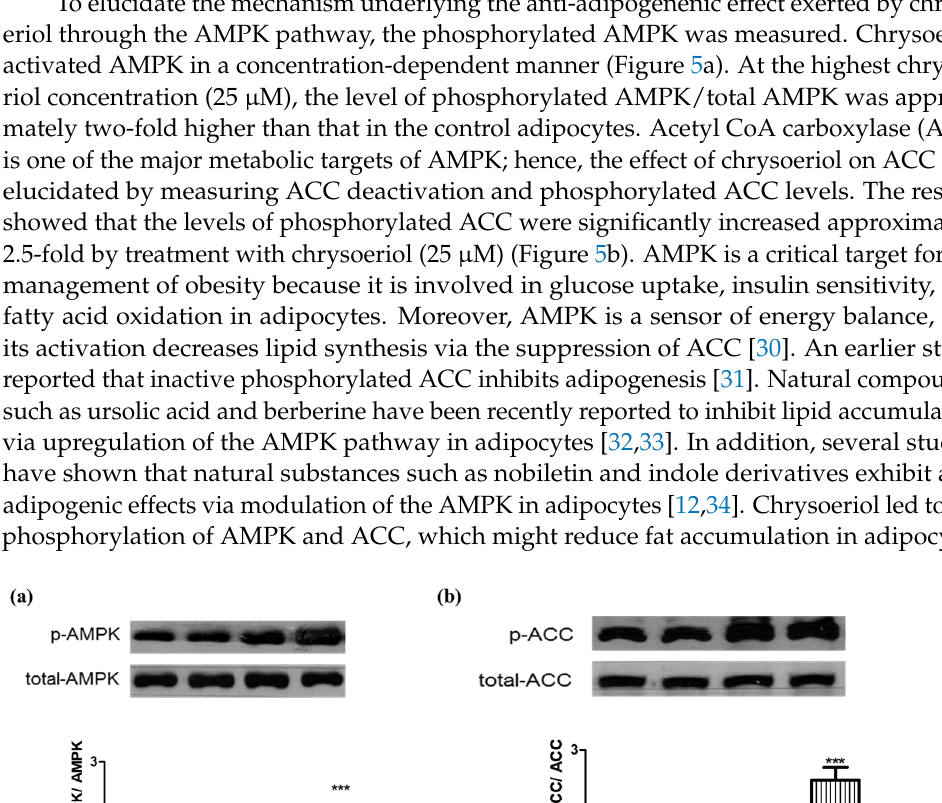
Figure 4. Effects of chrysoeriol on aP2 ( a ) and FAS ( b ) expression in 3T3-L1 adipocytes. *, **, *** p < 0.05, 0.01, and 0.001, respectively, significant difference compared with control group. CON, control (differentiated cells).